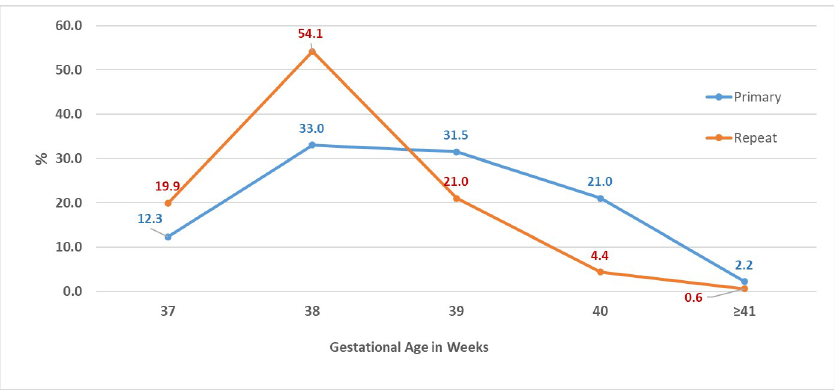
Fig 3. Distribution of gestational ages at delivery among primary and repeat elective